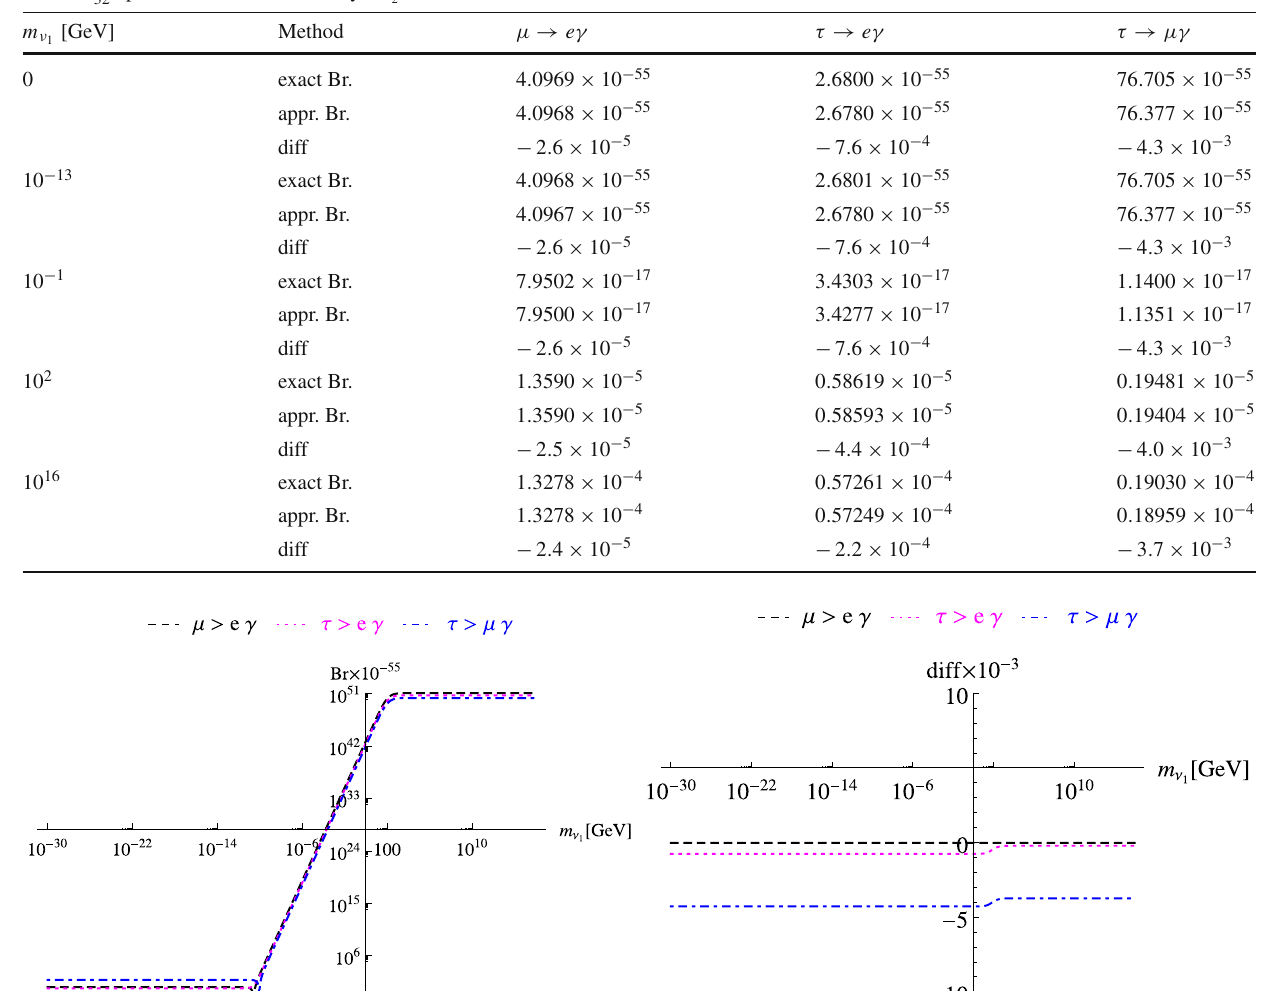
Table 2 Exact (i.e. m 1 and m 2 are kept in D L , R ) and approximate (i.e. m